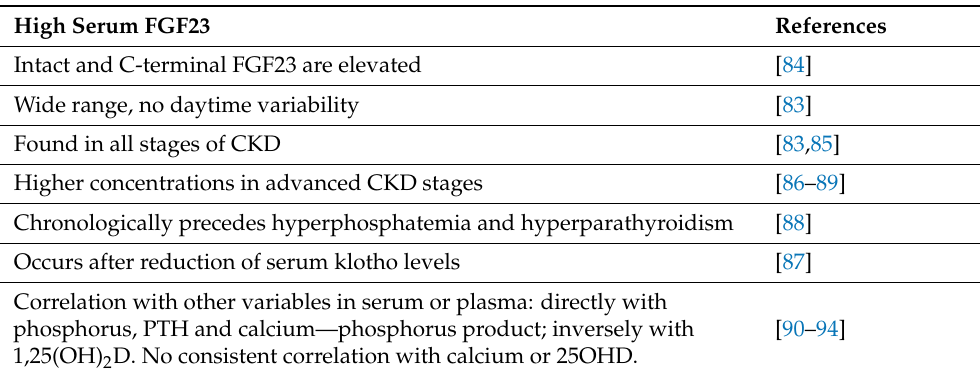
Table 6. Descriptive characteristics of elevated fibroblast growth factor 23 (FGF23) levels found in pediatric patients with chronic kidney disease (CKD) [83–94]. High Serum